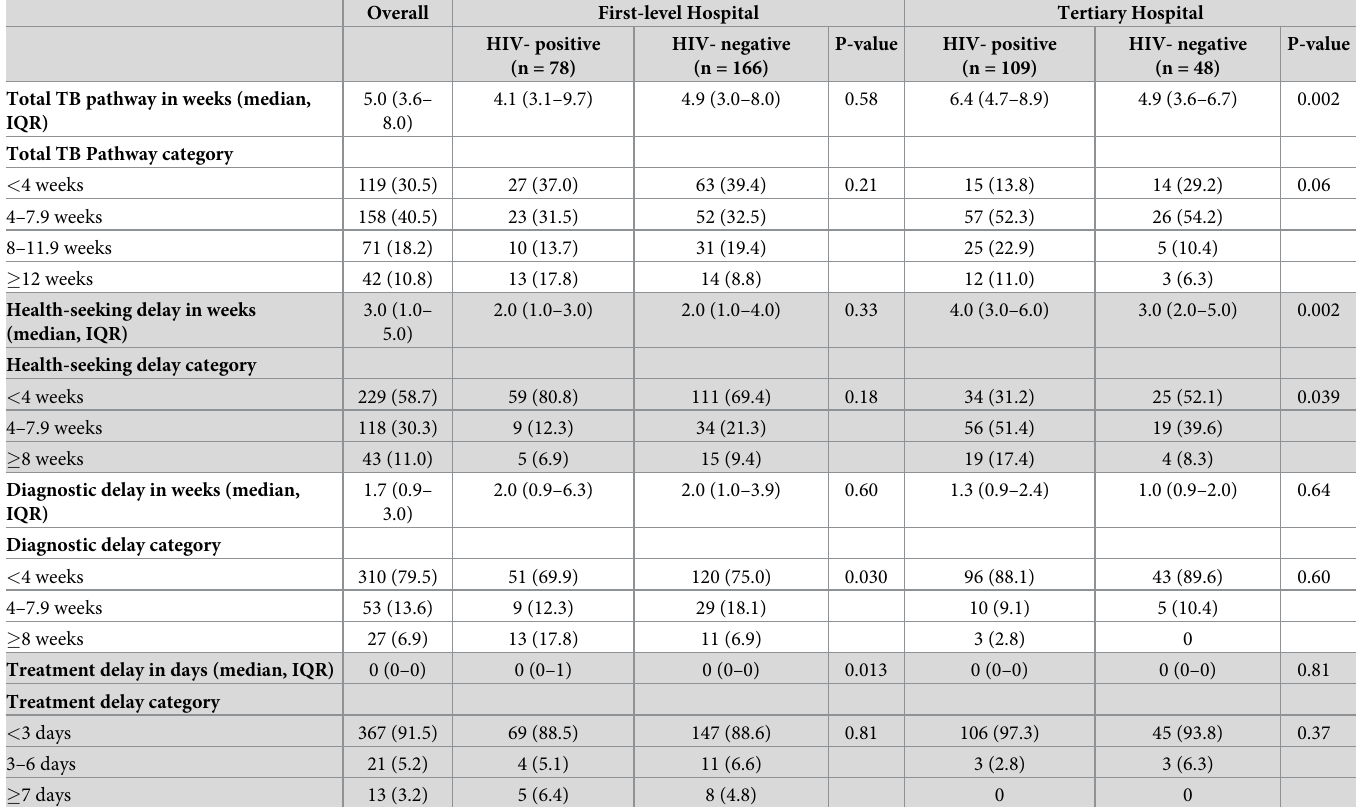
Table 3. Overview of TB patient care pathway according to enrollment site and HIV